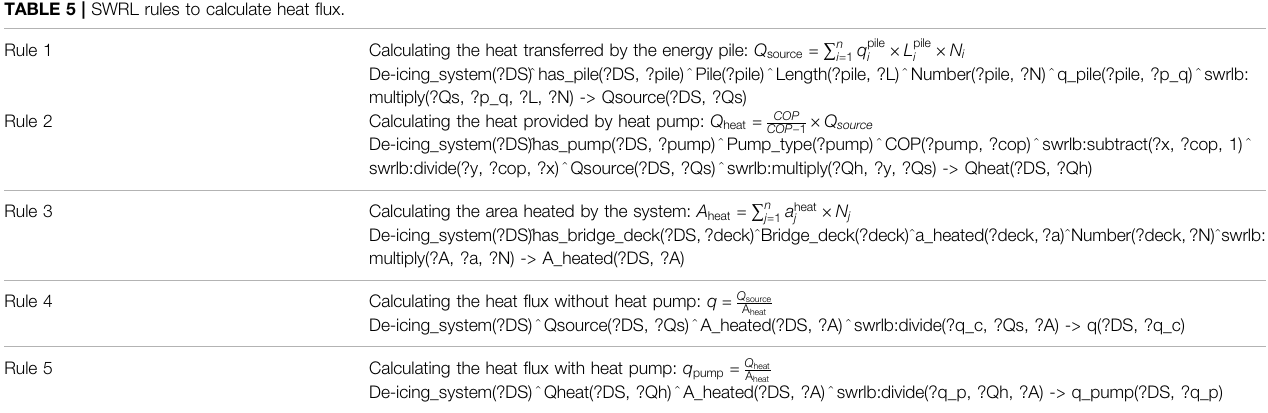
TABLE 5 | SWRL rules to calculate heat fl ux.